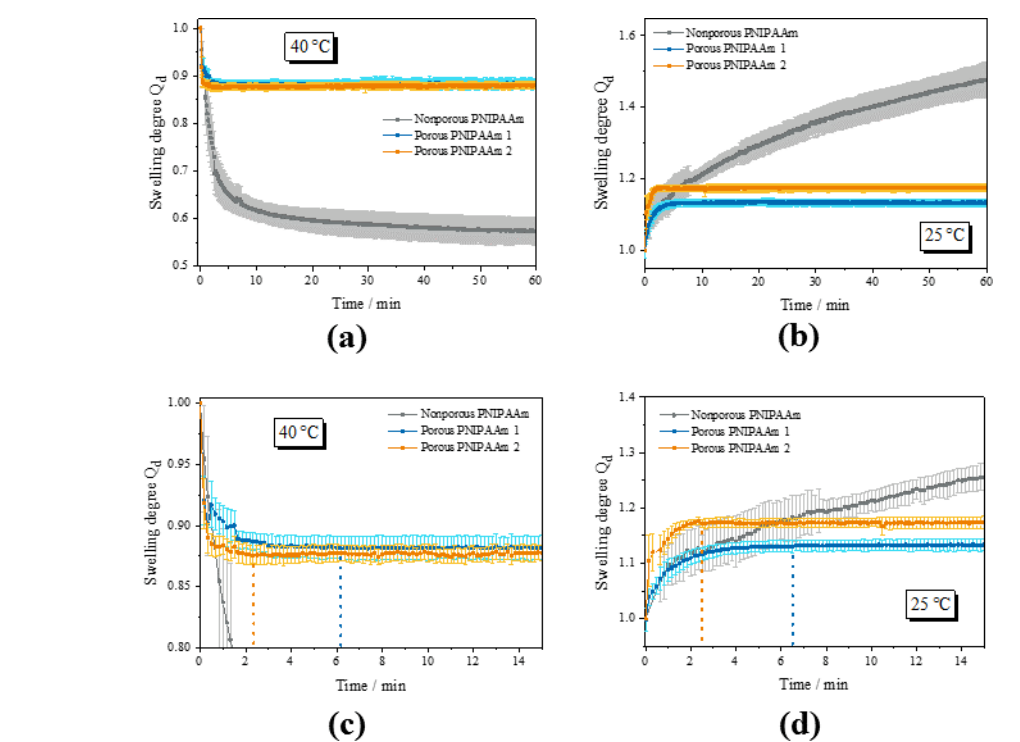
Figure 3. Results of the swelling experiments: (a, c) overview and detail of the deswelling experiments at 40 ◦ C; (b, d) overview and detail of the swelling experiments at 25 ◦ C; comparison of the swelling kinetics of nonporous and porous PNIPAAm samples. The dashed lines in (c) and (d) indicate the time when the swelling equilibrium (plateau) is reached.